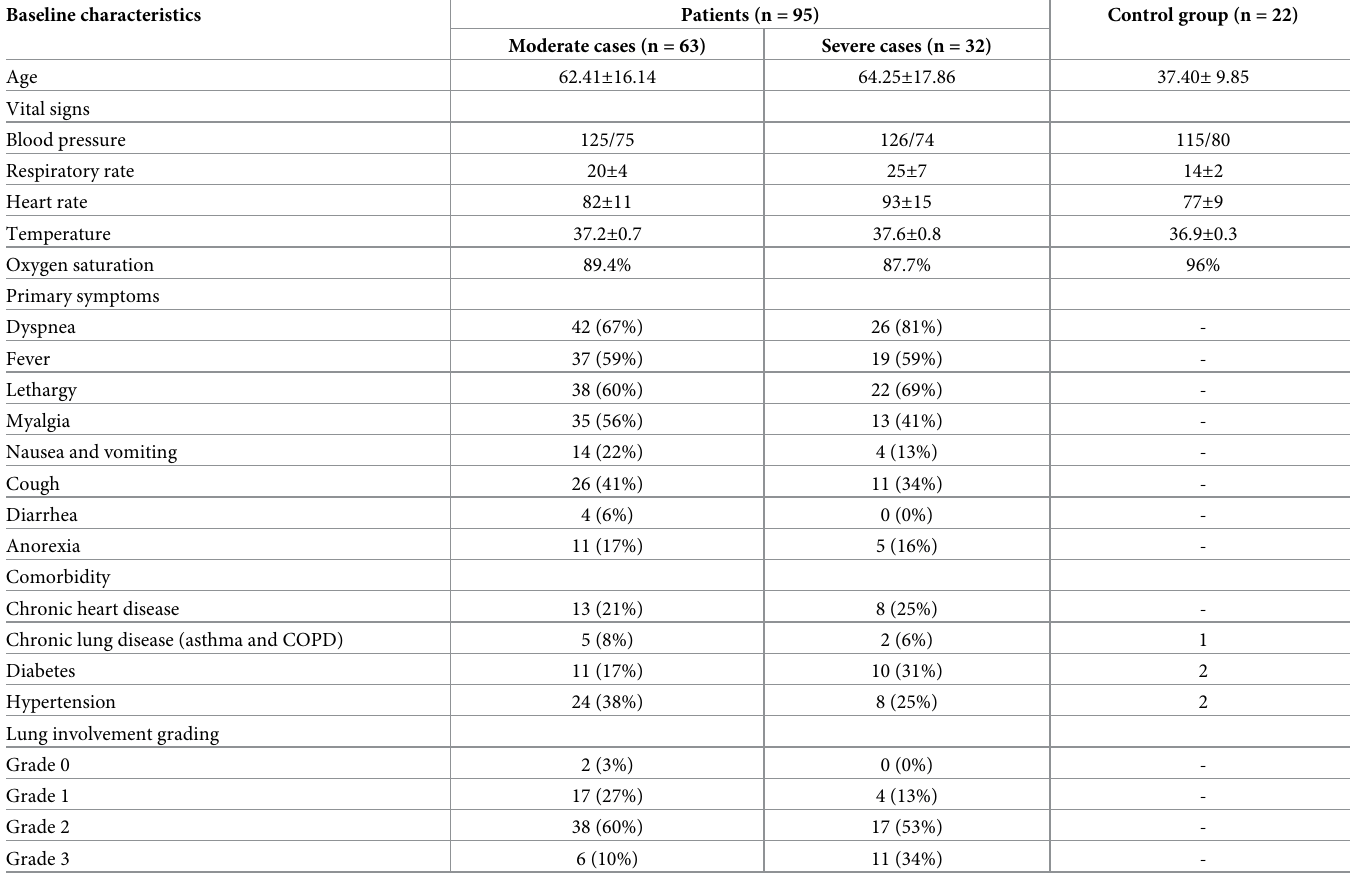
Table 1. Clinical and radiologic features of patients with Covid-19 and control